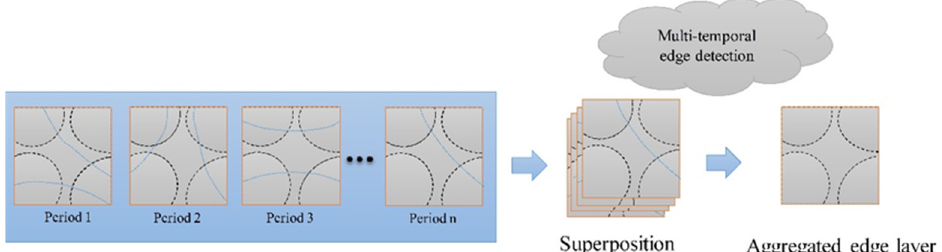
Figure 3. Edge detection based on multi-temporal images where the blue lines denote false edges and black dashed lines denote true edges.